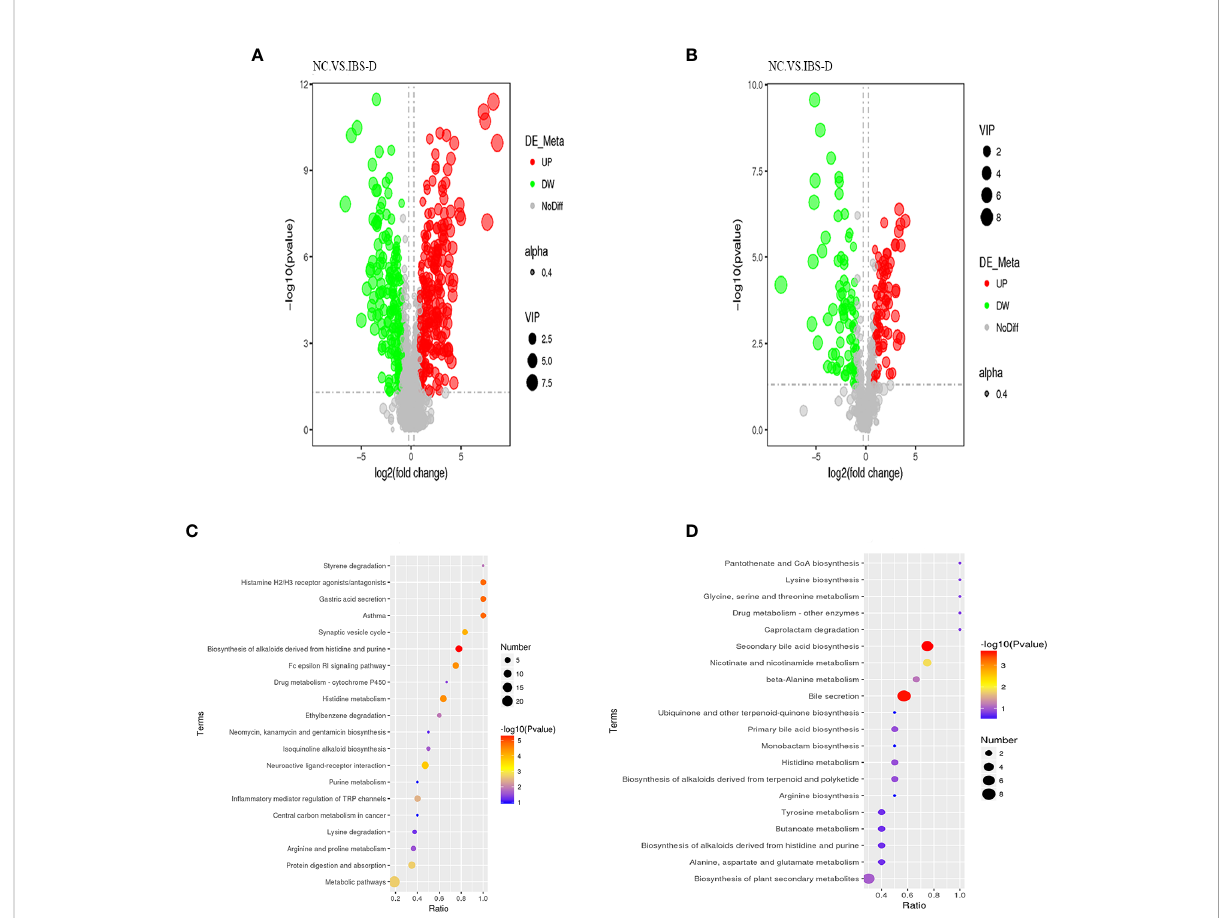
FIGURE 3 Nontargeted metabolites of the cocultured SJZD and intestine microbiota. (A, B) Volcano map of differentially expressed metabolites (DEM) from positive ion mode (A) and negative ion mode (B) . VIP: Variable importance in the projection. alpha: Transparency of dots. Black: the metabolite with no signi fi cant difference (nodiff), red: upregulated metabolite (up), green: downregulated metabolite (DW). (C, D) Bubble chart of enriched KEGG pathways, positive ion mode (C) and negative ion mode (D) . SJZD: Si-Jun-Zi Decoction. IBS-D: diarrhea-predominant irritable bowel syndrome.